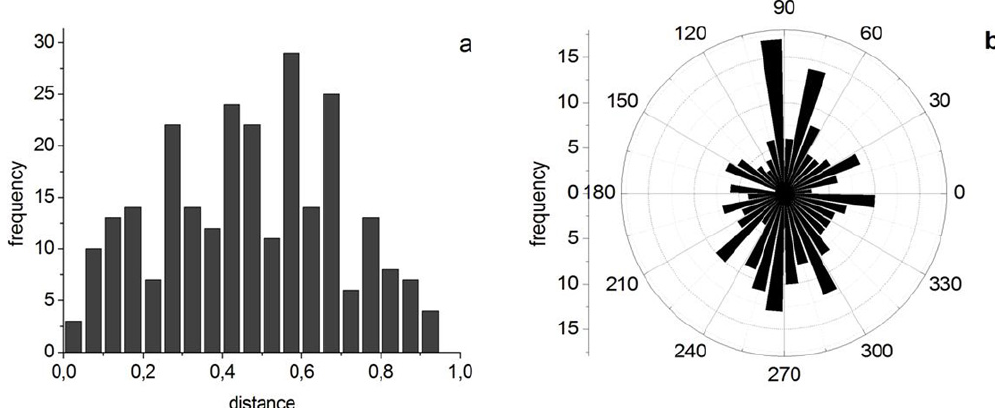
Fig. 7. Position of lakes within single basins: (a) frequency distribution of normalized distances between lake and basin centroids, (b) fre- quency distribution of angles (in ◦ ) between basin and lake centroids. 0 ◦ =East, 90 ◦ =North, 180 ◦ =West, 270 ◦ =South.